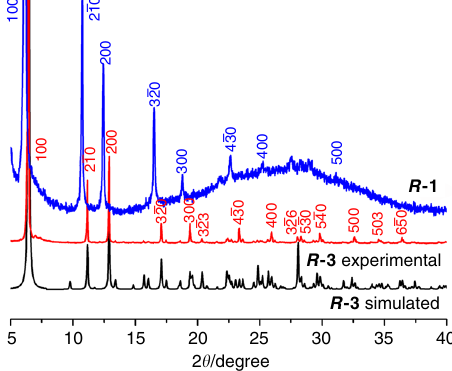
Fig. 5 PXRD patterns of R -1 helices and R -3 . The peaks are marked with the corresponding Miller indices. Simulated PXRD pattern of compound R -3 is also shown for the PXRD patterns of R -1 and R -3 were similar, as shown in Fig. 5. The re fl ections of ( h 00) for R -1 appeared as a series of strong and equidistant peaks with h up to 5 due to preferential orientation, which indicated that the helices possessed long-range intermolecular order and had a similar structure as that of the rod-like crystals of R -3 . The diffraction peaks can be indexed by using TOPAS 4.2 programme 42 , giving a set of unit cell para- meters with space group P 6 5 , a = 16.28 Å, c = 24.24 Å and V = 5564.9 Å 3 for R -1 (Supplementary Fig. 30). Compared with those